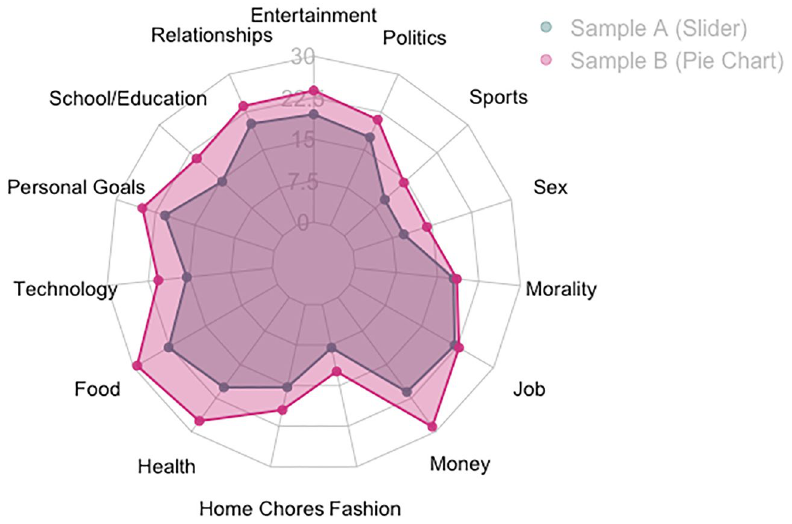
Figure 1. Participants’ estimation of frequency of different topics (Study